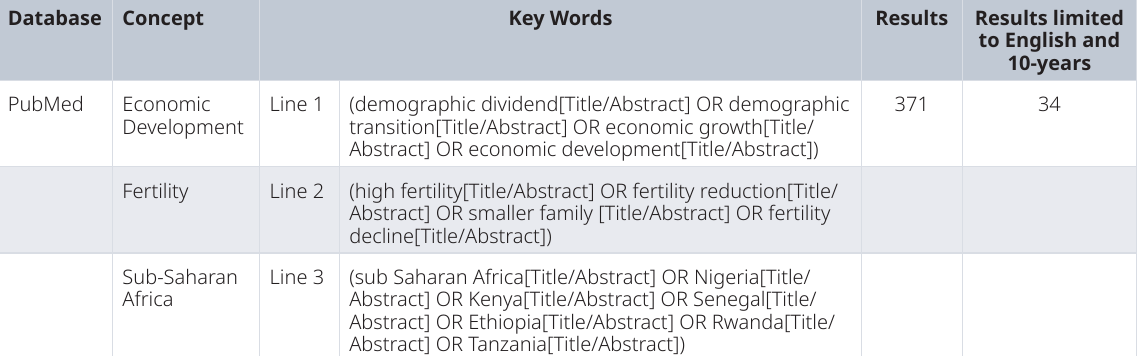
Table 1. Search strategy implemented on PubMed on 09/26/2018 to assess the relationship between fertility and economic development. Database